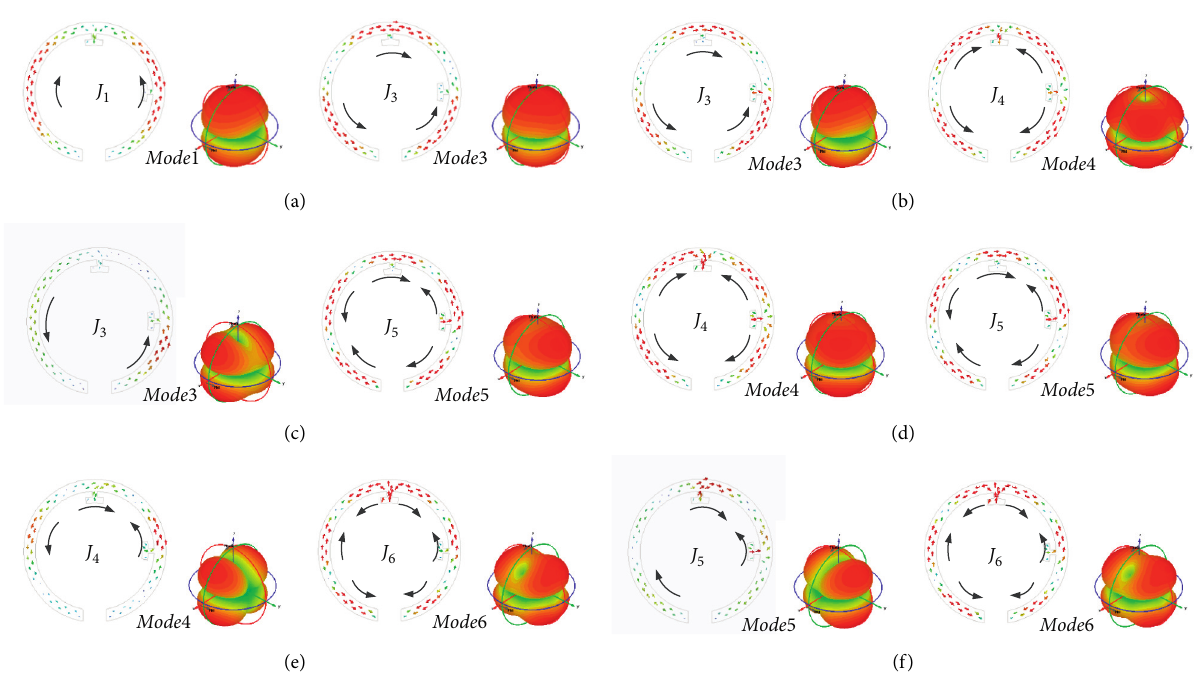
Figure 4: Modal currents and radiation patterns for the radiator of (a) Mode 1 and Mode 3 at 4.5 GHz. (b) Mode 3 and Mode 4 at 6 GHz. (c) Mode 3 and Mode 5 at 7.3 GHz. (d) Mode 4 and Mode 5 at 7.4 GHz. (e) Mode 4 and Mode 6 at 8.8 GHz. (f) Mode 5 and Mode 6 at 8.9 GHz.